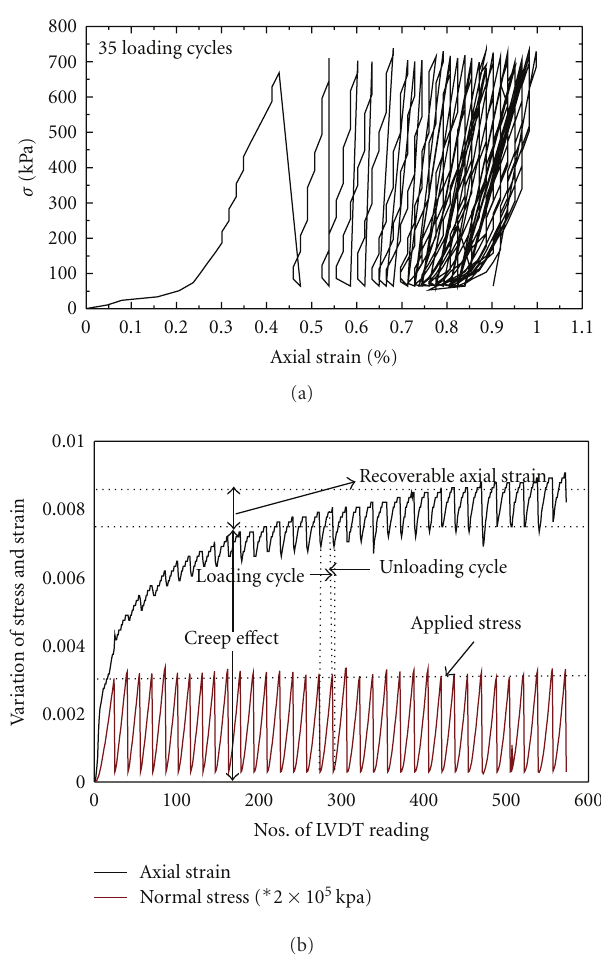
Figure 6: (a) A typical stress-strain curve obtained for a DAC specimen. (b) Stress-strain variation during loading.